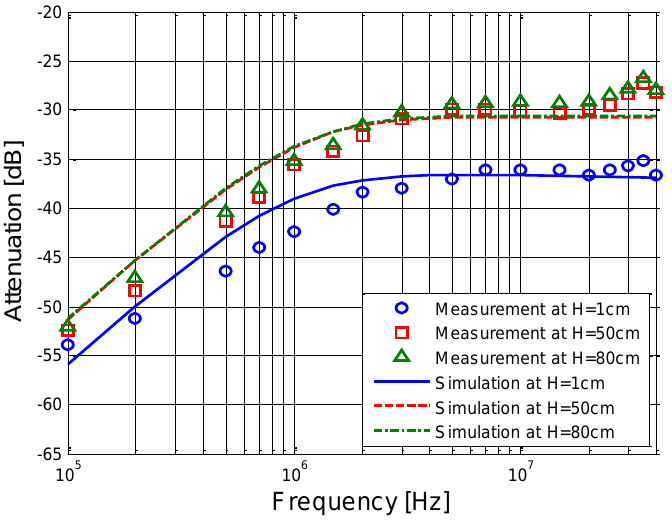
Figure 10. Comparison between the measurement results and simulation results corresponding to the different